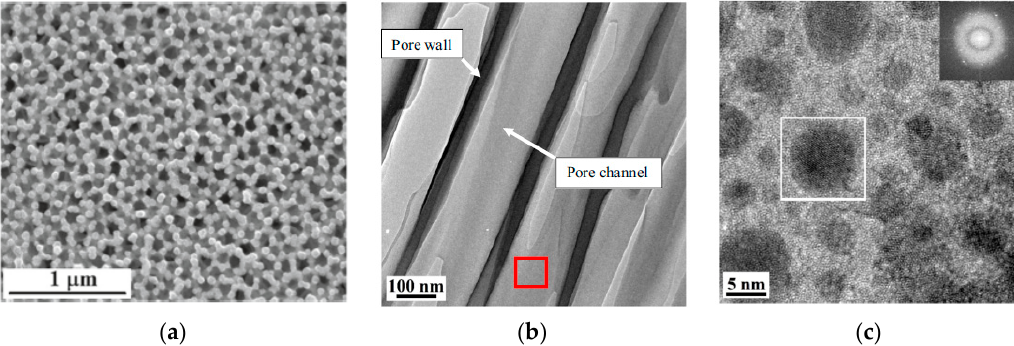
Figure 12. SEM micrograph of the anodized aluminium oxide (AAO) support ( a ) and TEM micrographs of the Pt/AAO catalyst ( b , c ) (reproduced from [130] with permission from Elsevier).